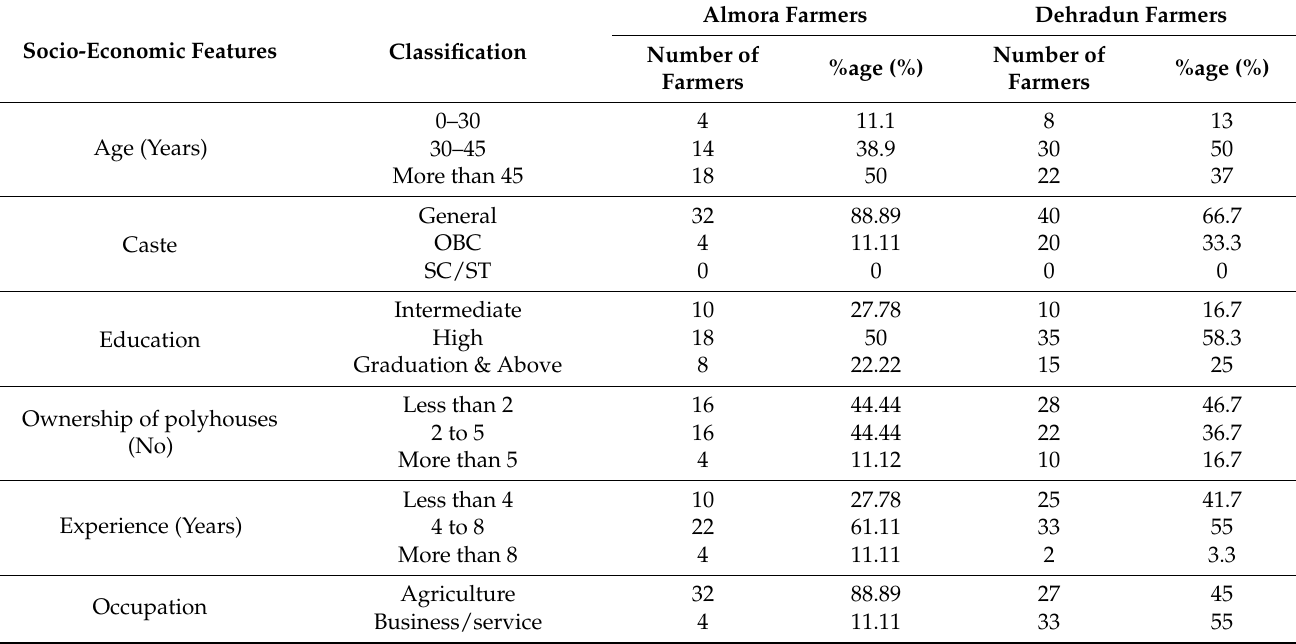
Table 7. Classification of farmers based on various socio-economic characteristics (N = 96).